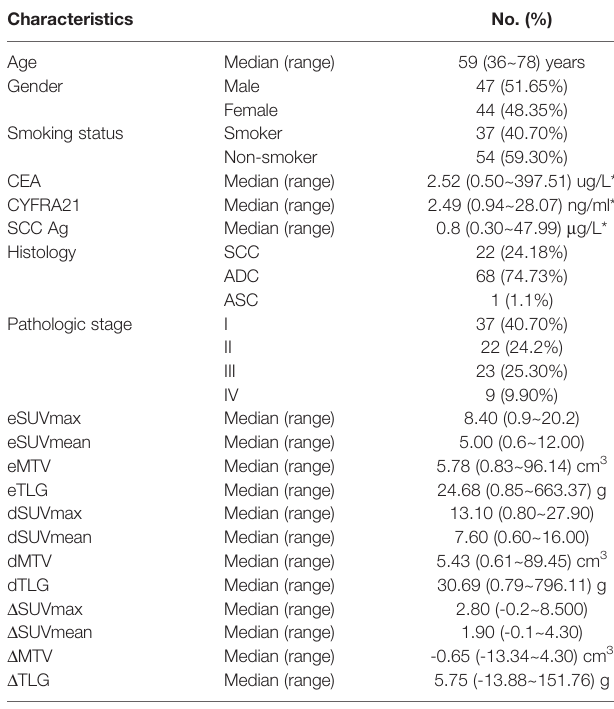
TABLE 1 | Demographic and clinical data of all